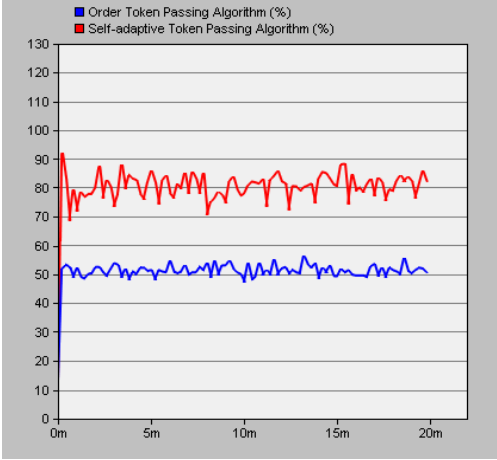
Fig.7 Improvement on time